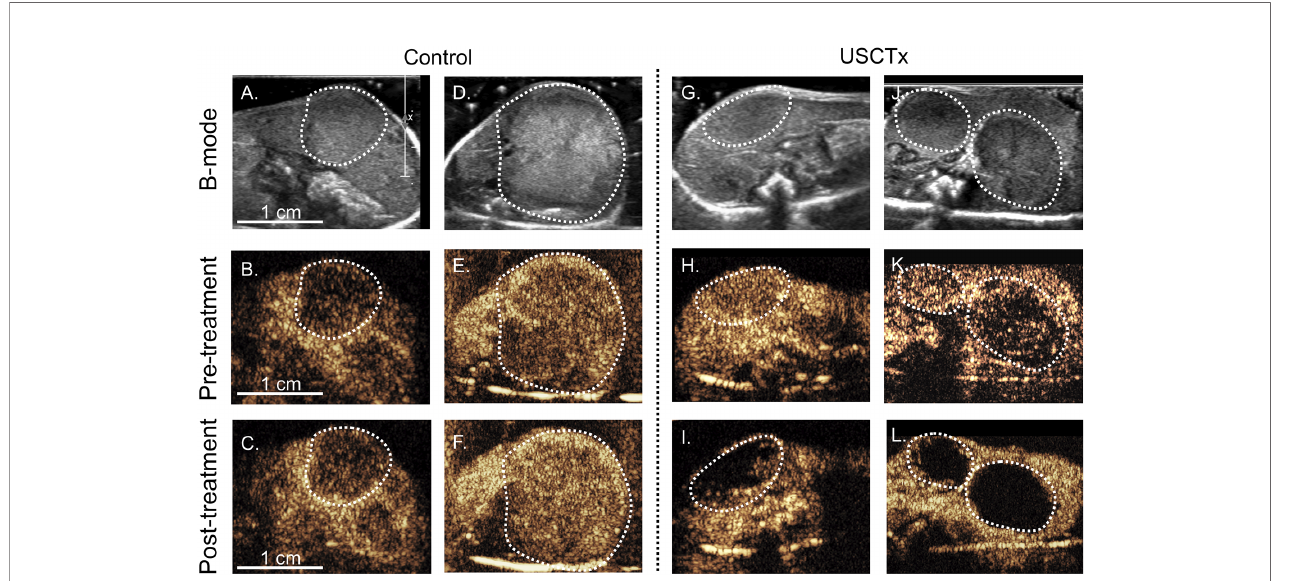
FIGURE 5 | Each column represents four different mice with tumors indicated by the dashed white line; (A – F) did not undergo USCTx while (G – L) did undergo USCTx. The top row (A, D, G, J) shows the initial b-mode images, the middle row (B, E, H, K) shows CEUS images taken 15 s after microbubble injection before treatment, and the bottom row (C, F, I, L) shows CEUS images taken 15 s after microbubble injection after treatment. Note reduced presence of microbubbles post-treatment in the USCTx mice (I, L) and similarities in microbubble presence in the control mice (C, F)